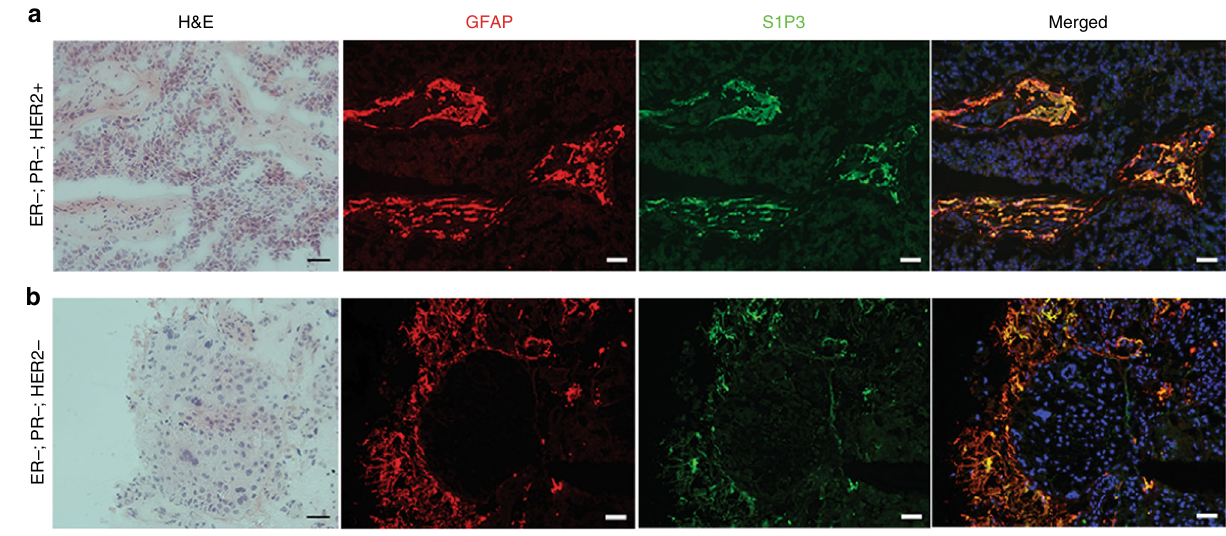
Fig. 4 S1P3 is expressed in the neuroin fl ammatory response of patients ’ brain metastasis specimens. Fresh frozen sections of nine resected brain metastases of breast and lung cancers, nine of which were previously described 19 , were stained for S1P3 (green) and GFAP (red). Nuclei are DAPI stained (blue). a Specimen #4, ER-, PR-, HER2 + breast cancer. b Specimen #5, ER-, PR-, HER2 + breast cancer. Co-staining of S1P3 and activated astrocytes in the tumor microenvironment is seen. A summary of all staining is presented in Supplementary Data 3. (Scale bar = 50 µ m)